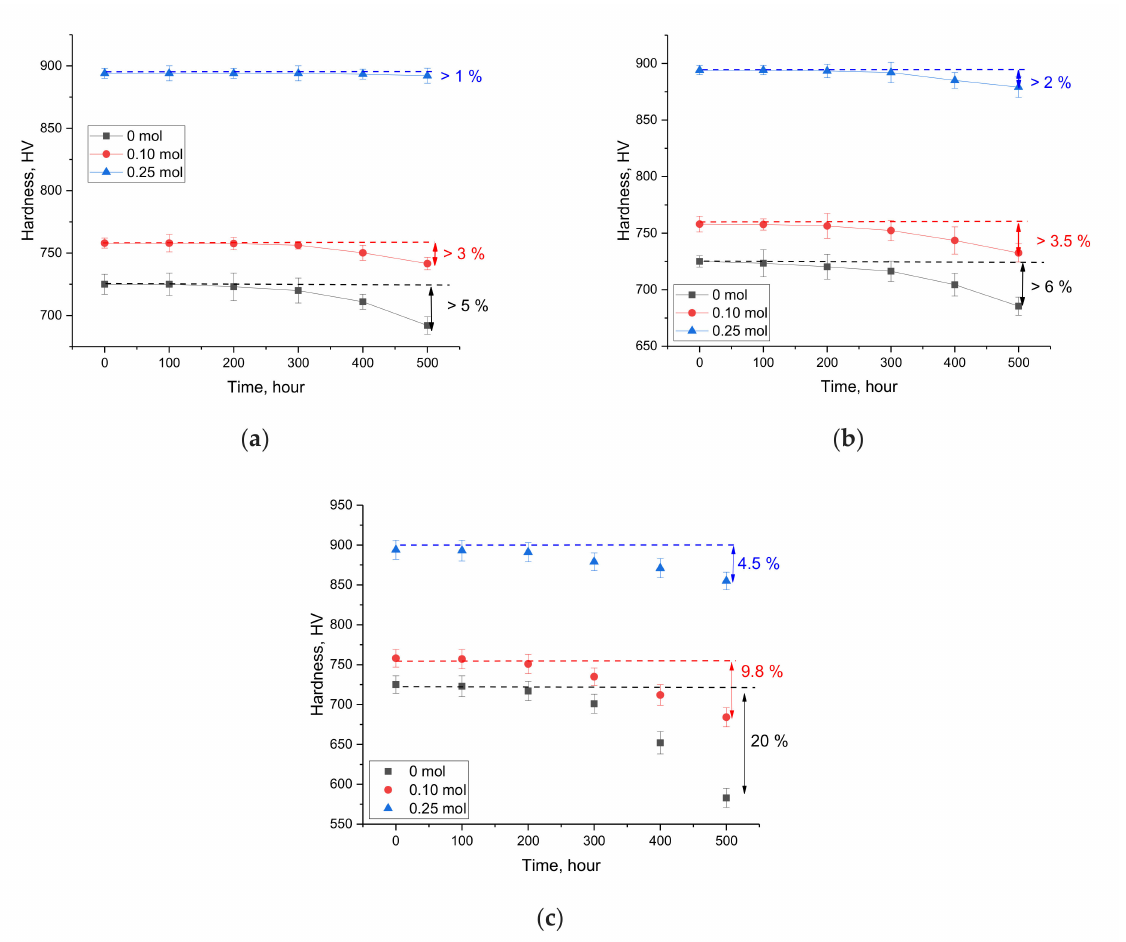
Figure 6. Results of the change in the hardness value of ceramics depending on time in thermal aging tests: ( a ) 500 K; ( b ) 600 K; ( c ) 700 K. In the case of an aging temperature of 700 K in the case of undoped Li 2 TiO 3 ceramics, the maximum decrease in hardness was more than 20% after 500 h of testing, which indi- cates a strong degradation of the strength properties of ceramics (an example is shown in Figure 7). In this case, doping and the subsequent formation of the Li 0.94 Ni 1.04 Ti 2.07 O 7 phase leads to a more than twofold increase in the resistance of ceramics to high-temperature aging for two-phase Li 2 TiO 3 /Li 0.94 Ni 1.04 Ti 2.07 O 7 ceramics, and a fourfold increase for single-phase Li 0.94 Ni 1.04 Ti 2.07 O 7